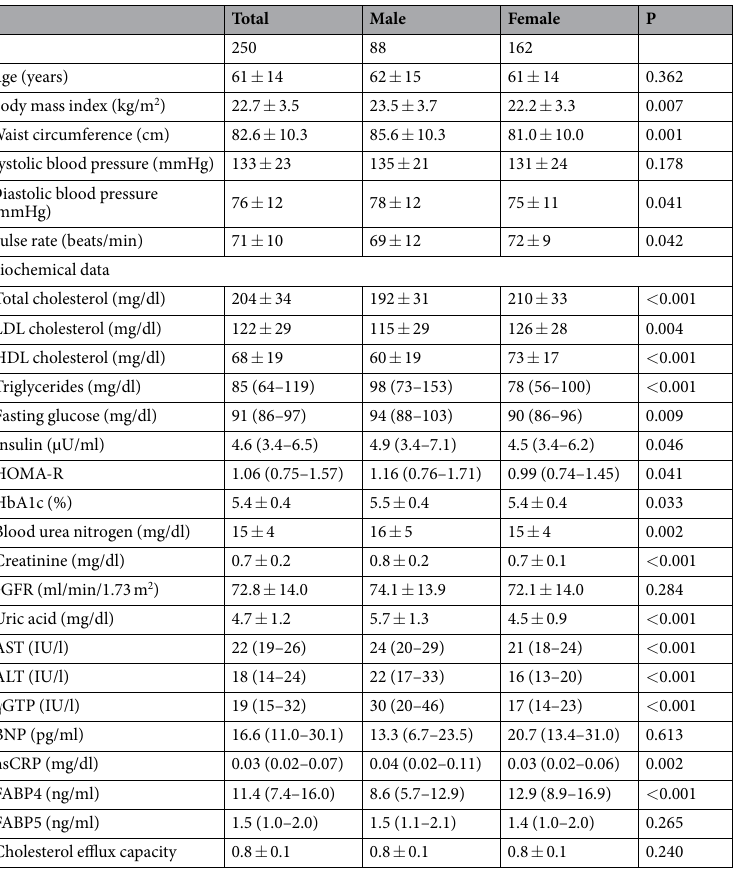
Table 1. Characteristics of the studied subjects without medication (n = 250). Variables are expressed as number, means ± SD or medians (interquartile ranges). AST, Aspartate transaminase; ALT, Alanine transaminase; BNP, brain natriuretic peptide. eGFR, estimated glomerular filtration rate; FABP4, fatty acid-binding protein 4; FABP5, fatty acid-binding protein 5. γ GTP, γ -glutamyl transpeptidase; hsCRP, high- sensitivity C-reactive